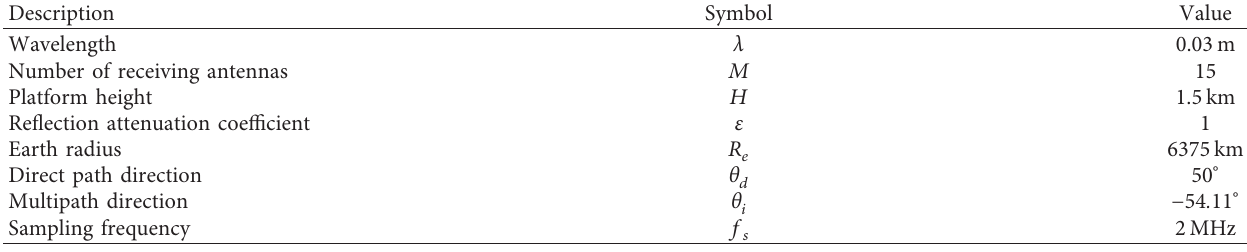
Table 1: System parameters.